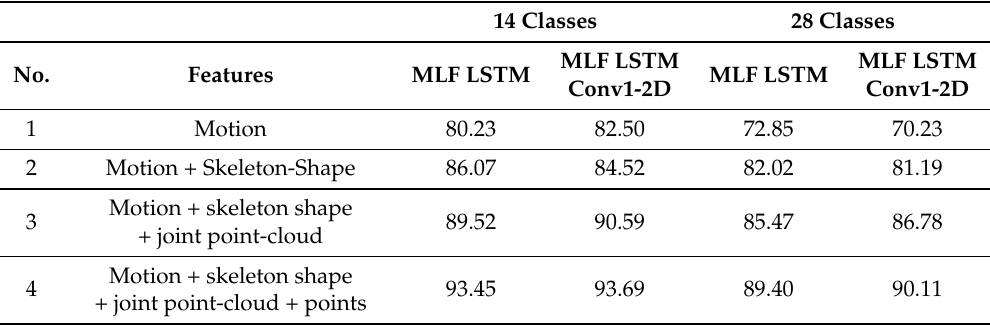
Table 7. Performance results on the skeleton data.